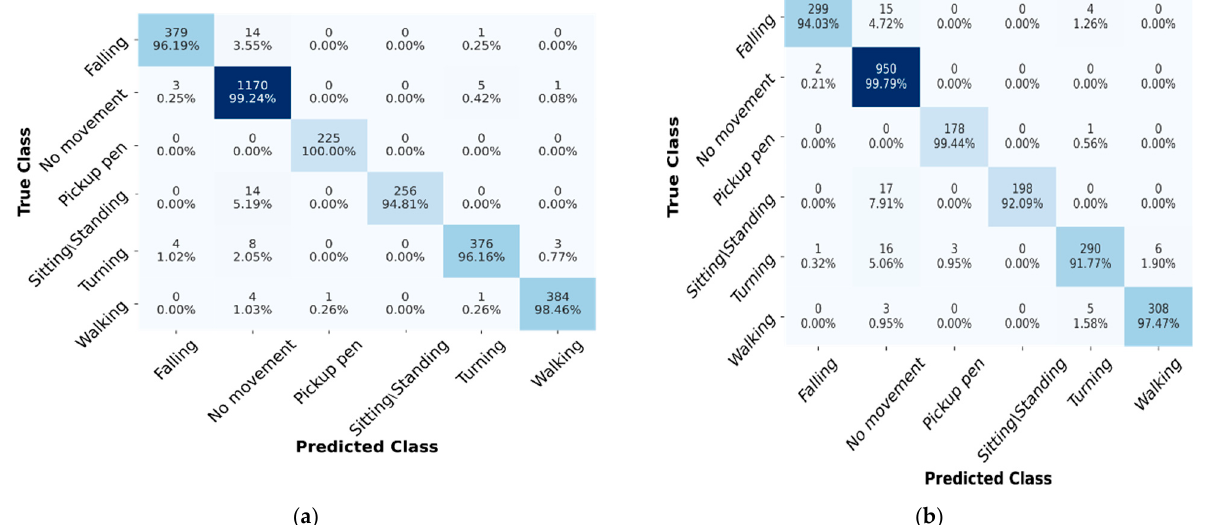
Figure 8. Confusion Matrix of the proposed STC-NLSTMNet model on LOS. ( a ) E1. ( b ) E2. The accuracy and loss history graphs of the STC-NLSTMNet model are displayed in Figure 9. The training and testing graph (Figure 9a) of the STC-NLSTMNet model converges quite quickly within 100 epochs. It is rational for the training loss to be relatively higher than the testing loss, as shown in Figure 9b. This is because the training involves going through numerous phases to learn the various CSI signal patterns among different activities.